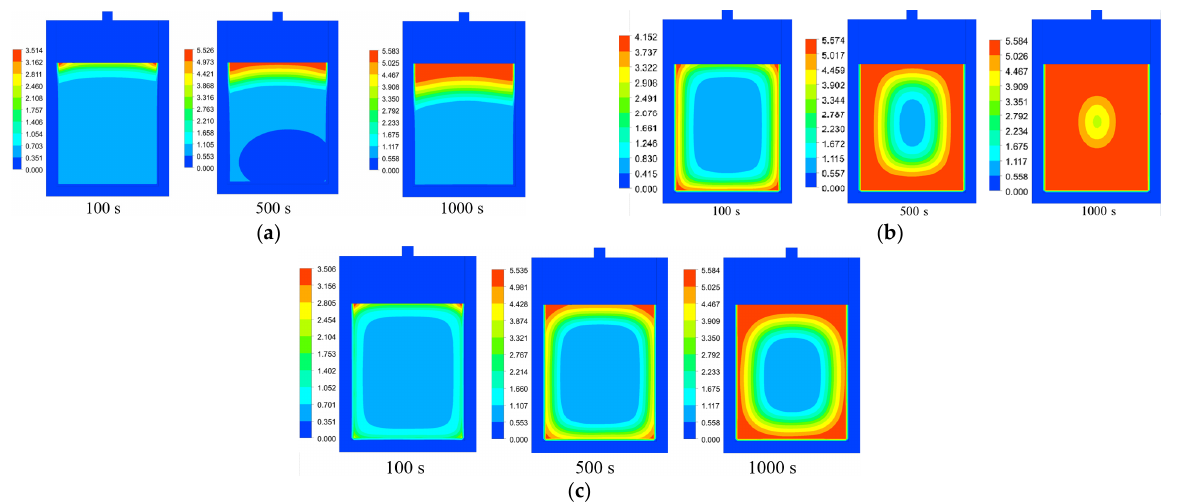
Figure 12. A hydrogen storage capacity distribution cloud chart at different times of the reaction tank selecting air, water, and oil as the cooling media. ( a ) Air as the cooling medium; ( b ) Water as the cooling medium; ( c ) Oil as the cooling medium.